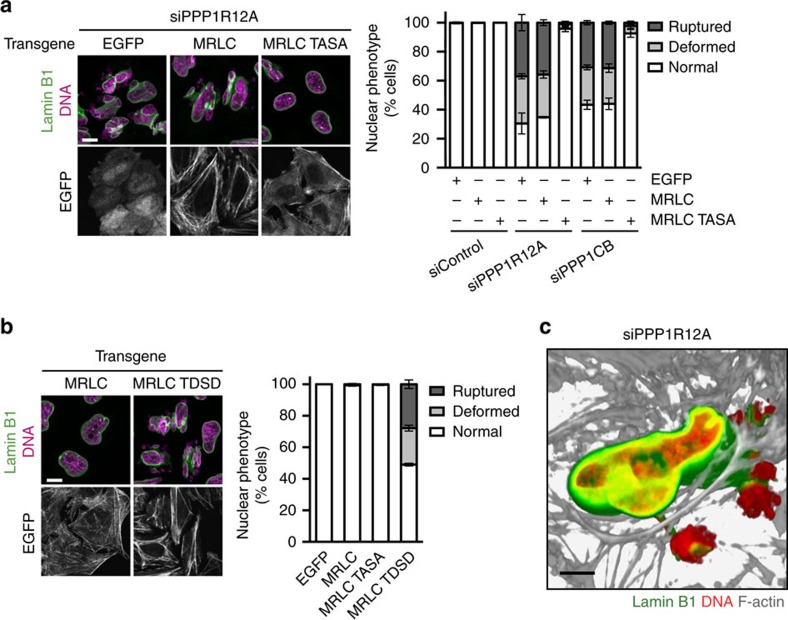
Deregulation of MRLC phosphorylation causes ectopic actomyosin fibre formation and nuclear deformation.(a) HeLa Kyoto cells were transduced with lentiviral particles encoding EGFP, MRLC-EGFP wildtype or MRCL-EGFP T18A S19A (TASA). 15 h after infection, cells were transfected with the indicated siRNA duplexes and processed for immunofluorescence analysis 56 h after transfection. Only EGFP signal-positive cells were scored. Representative cell images (left panel) and quantification of nuclear phenotype (right panel) are shown. (b) HeLa Kyoto cells were infected with lentiviral particles encoding MRLC-EGFP wildtype or a T18D S19D mutant (TDSD) and processed for immunofluorescence analysis 56 h after infection. Only EGFP signal-positive cells were scored. Representative cell images (left panel) and quantification of nuclear phenotype (right panel) are shown. (c) PPP1R12A-depleted cells were fixed and stained for with anti-lamin B1 antibodies, DAPI and fluorophore-conjugated phalloidin. Cells were scanned in 0.1 μm sections using confocal laser scanning microscopy. The 3D image was reconstituted and rendered using Imaris software. Error bars, s.d. of three independent experiments (n>200 cells each) (a,b). Scale bars, 10 μm.